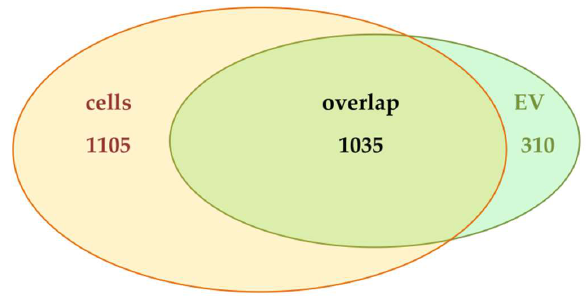
Figure 5. Venn diagram analysis of proteins identified in HCT116-TGFBR2 cells ( yellow ) and EVs ( green ) derived thereof. Numbers of proteins per intersection are given.